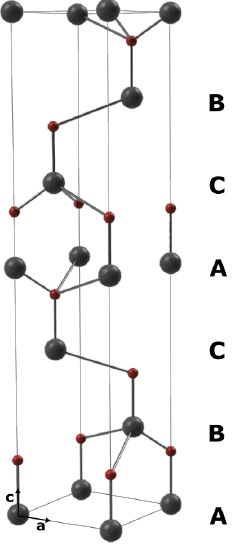
Figure 1. The 6H stacking sequence of